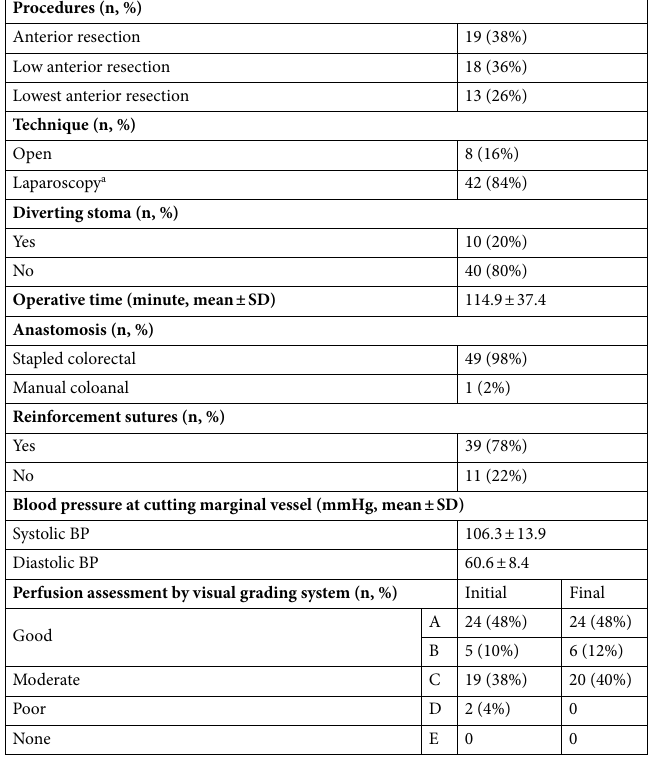
Table 3. Description of surgical procedure and perfusion assessment (n = 50). SD standard deviation. a One case, open conversion due to tumor invasion to uterus.